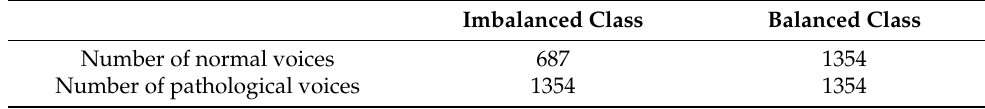
Table 1. Number of samples in the experimental